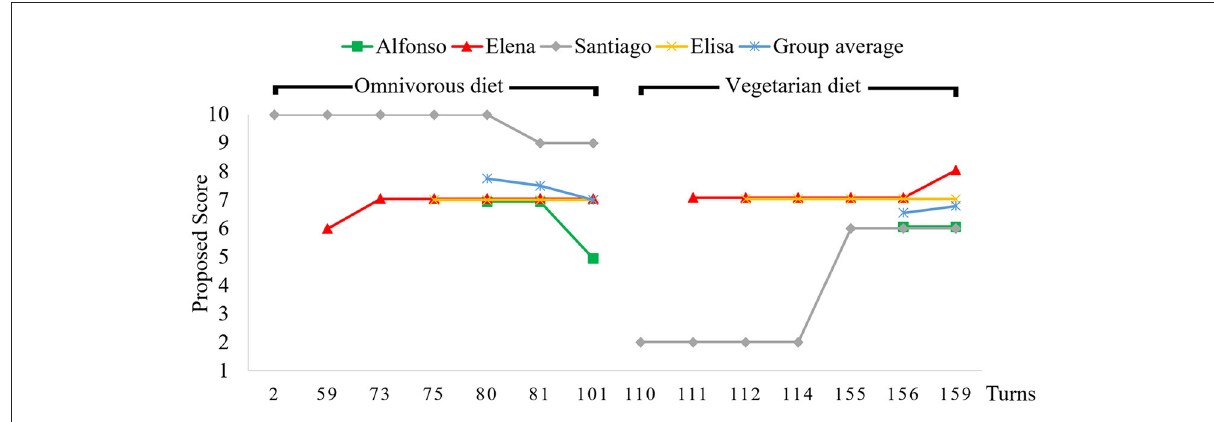
FIGURE1 Evolution of the proposed scores for the nutritional acceptability of omnivorous and vegetarian diets throughout the